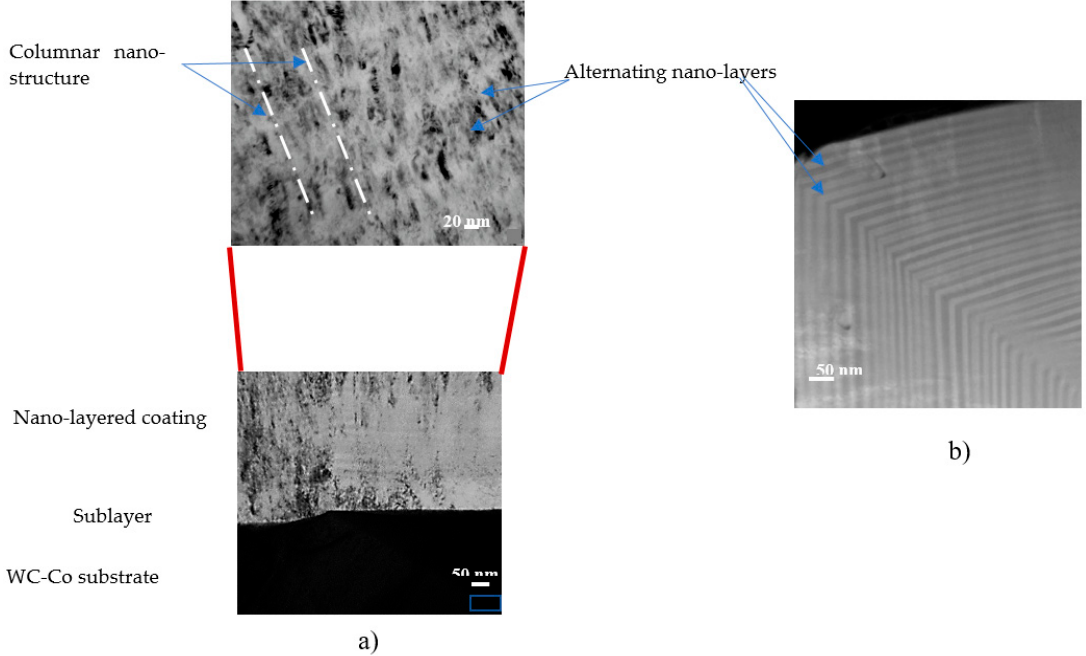
Figure 9. TEM (transmission electron microscope) image of FIB cross-section of TiAlCrSiYN / TiAlCrN bi-multilayer coating: ( a ) Thickness of alternating nano-layers in multilayered coatings is 20–40 nm, thickness of TiAlCrN sublayer is 100 nm; ( b ) FIB cross-section of the multilayer coating on the cutting edge of the tool [28].